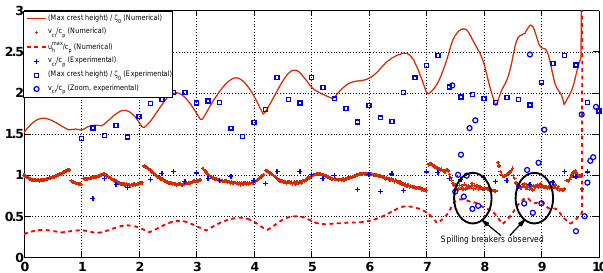
Figure 10. Variation along the tank of the maximum crest heights, propagation velocity of the highest crests, and the water particle velocity at those crests. Red lines denote numerical results, blue symbols experiments. The locations where breaking was observed in the experiments are